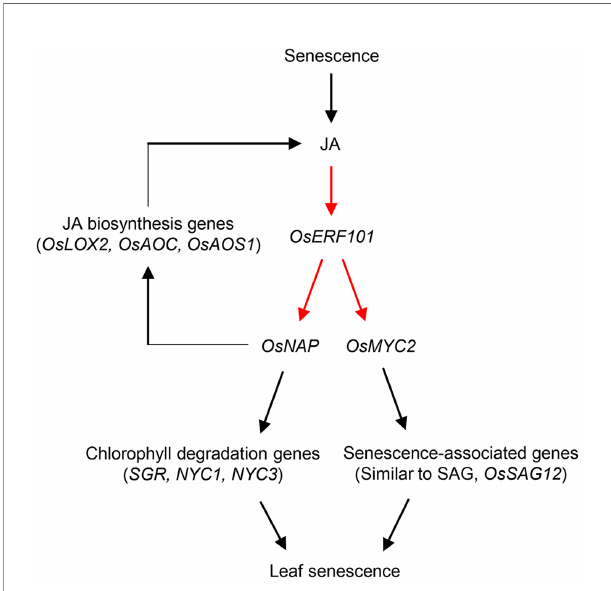
FIGURE 7 | Proposed model of the role of OsERF101 in the regulation in leaf senescence through JA signaling pathways involving OsNAP and OsMYC2 . Red arrows indicate our fi ndings in this study, and black arrows represent pathways identi fi ed in previous studies (Zhou et al., 2013; Liang et al., 2014; Uji et al.,